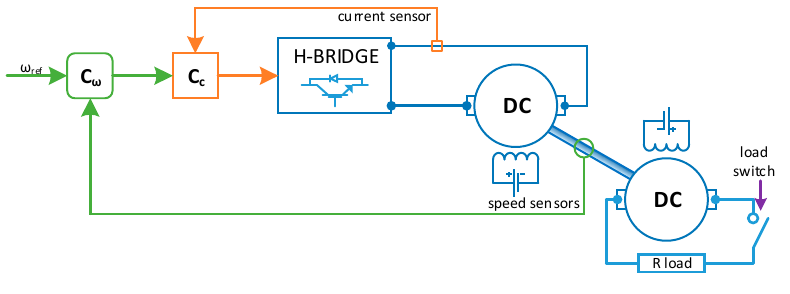
Figure 4. Control system scheme.